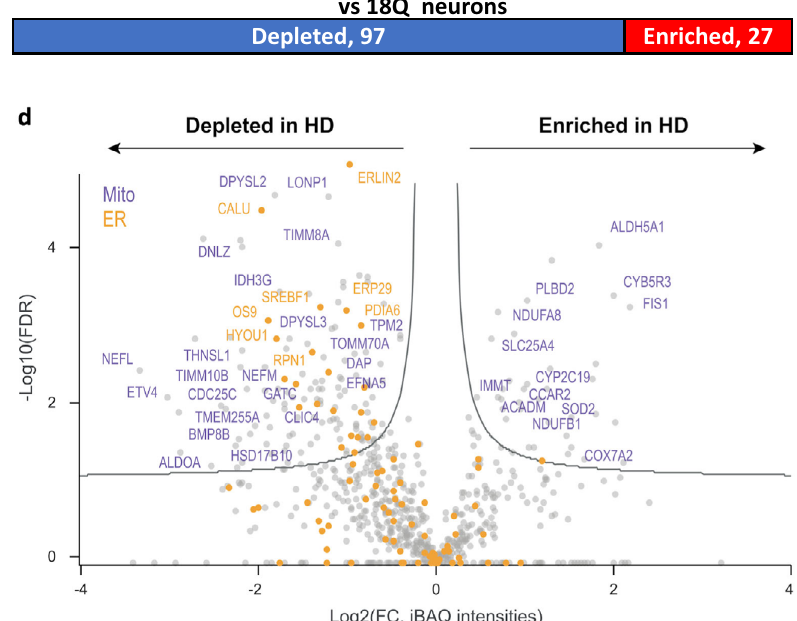
Fig. 1 and quantitated in Fig. 9. c Mass spectrometry of proteins in isolated mito- chondriashowed177differentiallyenrichedpeptides,ofwhich124wereuniqueto acertainprotein. d Scatterplotshowingfoldchangeofpeptides(X)vsthelogfalse discovery rate(Y) of the 177 peptides highlighting selected proteins that were depletedorincreasedinHD(Q109)mitochondriaincomparisontocontrols(Q18). Mitochondrial proteins are colored in purple and ER proteins in